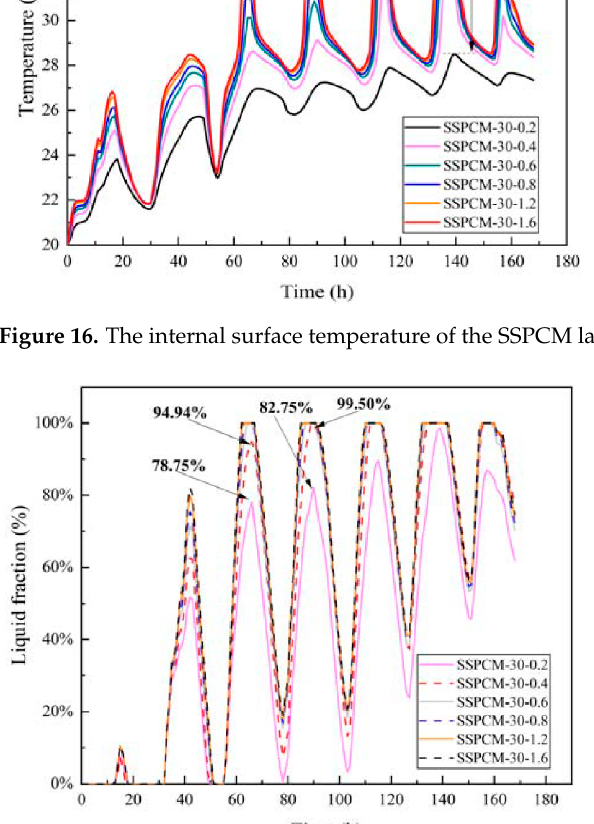
Figure 17. The liquid fraction of the SSPCM layer with different thermal conductivities.